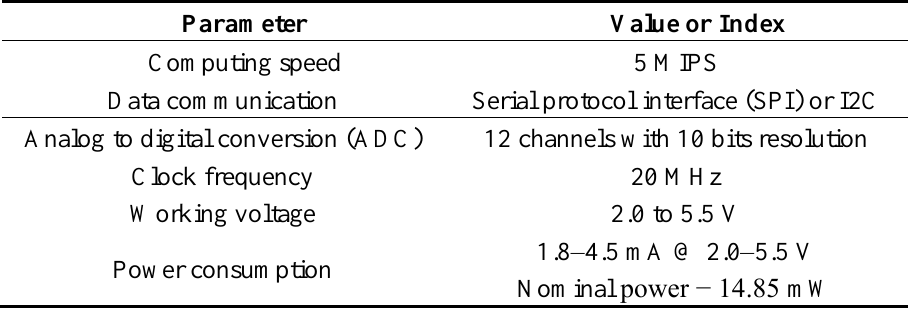
Table 1. Parameters of the signal